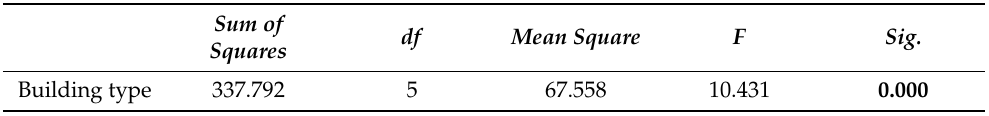
Table 9. ANOVA analysis for DTR.